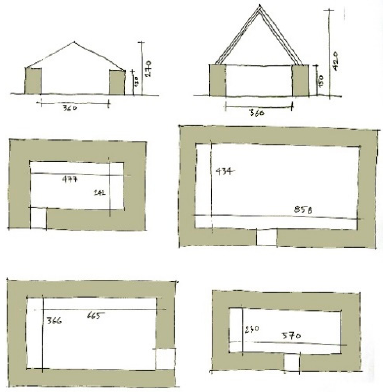
Figure 18. Cross-sections through two types of gladas and examples of plans of gladas of different dimensions, drawing: A. Kapetanovi ć .